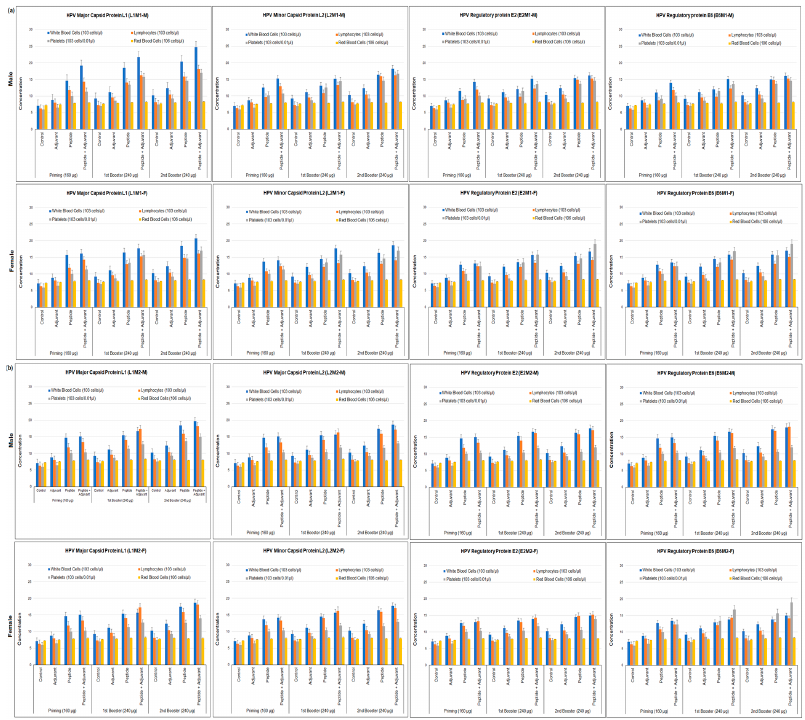
Figure 3. Hematological assays show the cellular count of white blood cells (WBCs), lymphocytes (LYM), platelets (PLT) and red blood cells (RBCs) in serum samples of male and female rats immunized with ( a ) MHC class-I ( b ) MHC Class-II specific monovalent antigenic peptides (individual peptides) emulsified with and without adjuvant at primary, first and second booster doses. All data were compared to control group.